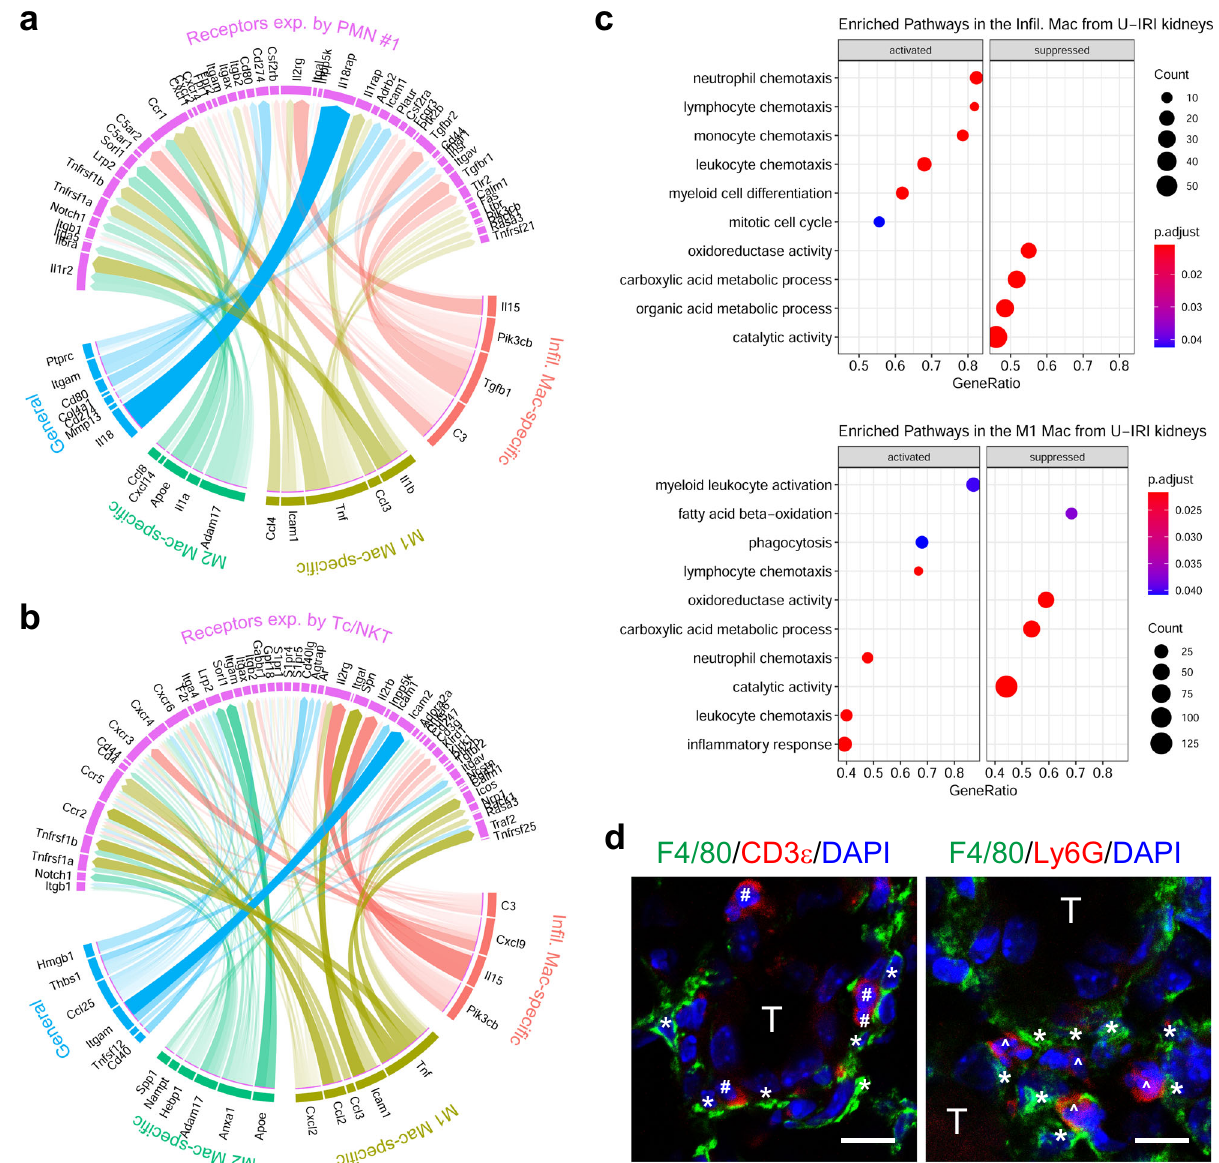
Fig. 6 | U-IRI promotes a second wave of immune cell recruitment. Wild-type mice were subjected to 27min of ischemia/reperfusion injury (IRI) with con- tralateral nephrectomy (IRI/CL-NX) or unilateral IRI (U-IRI) and sacri fi ced on day 7, 14,and 30 after injury. Injured kidneys and normalcontrol kidneys were harvested for single-cell-RNA-sequencing analysis as shown in Fig. 3. a , b Genes that were differentially expressed on day 14 after injury by the in fi ltrating (In fi l.), M1, M2 macrophages (Mac), and in any combination (General) in U-IRI kidneys as com- pared to IRI/CL-NXkidneyswere linkedto theircorresponding receptorsbased on